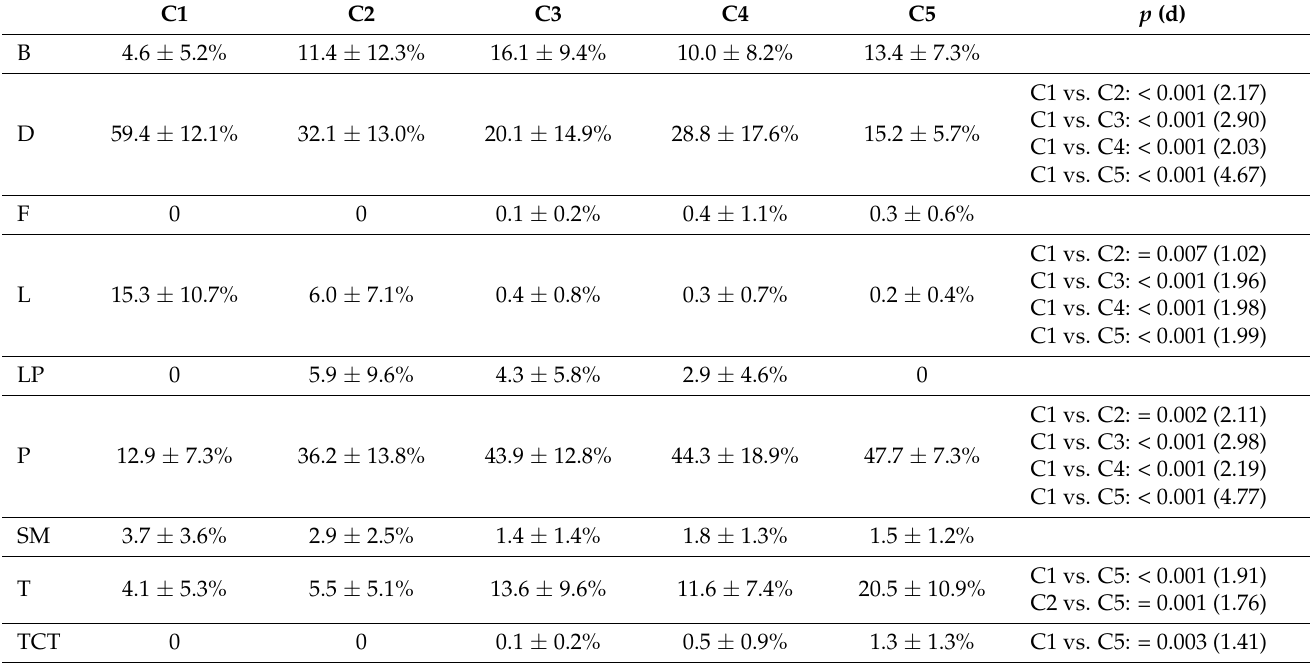
Table 4. Distribution of strokes type (serve excluded) for each class (mean ± SD).